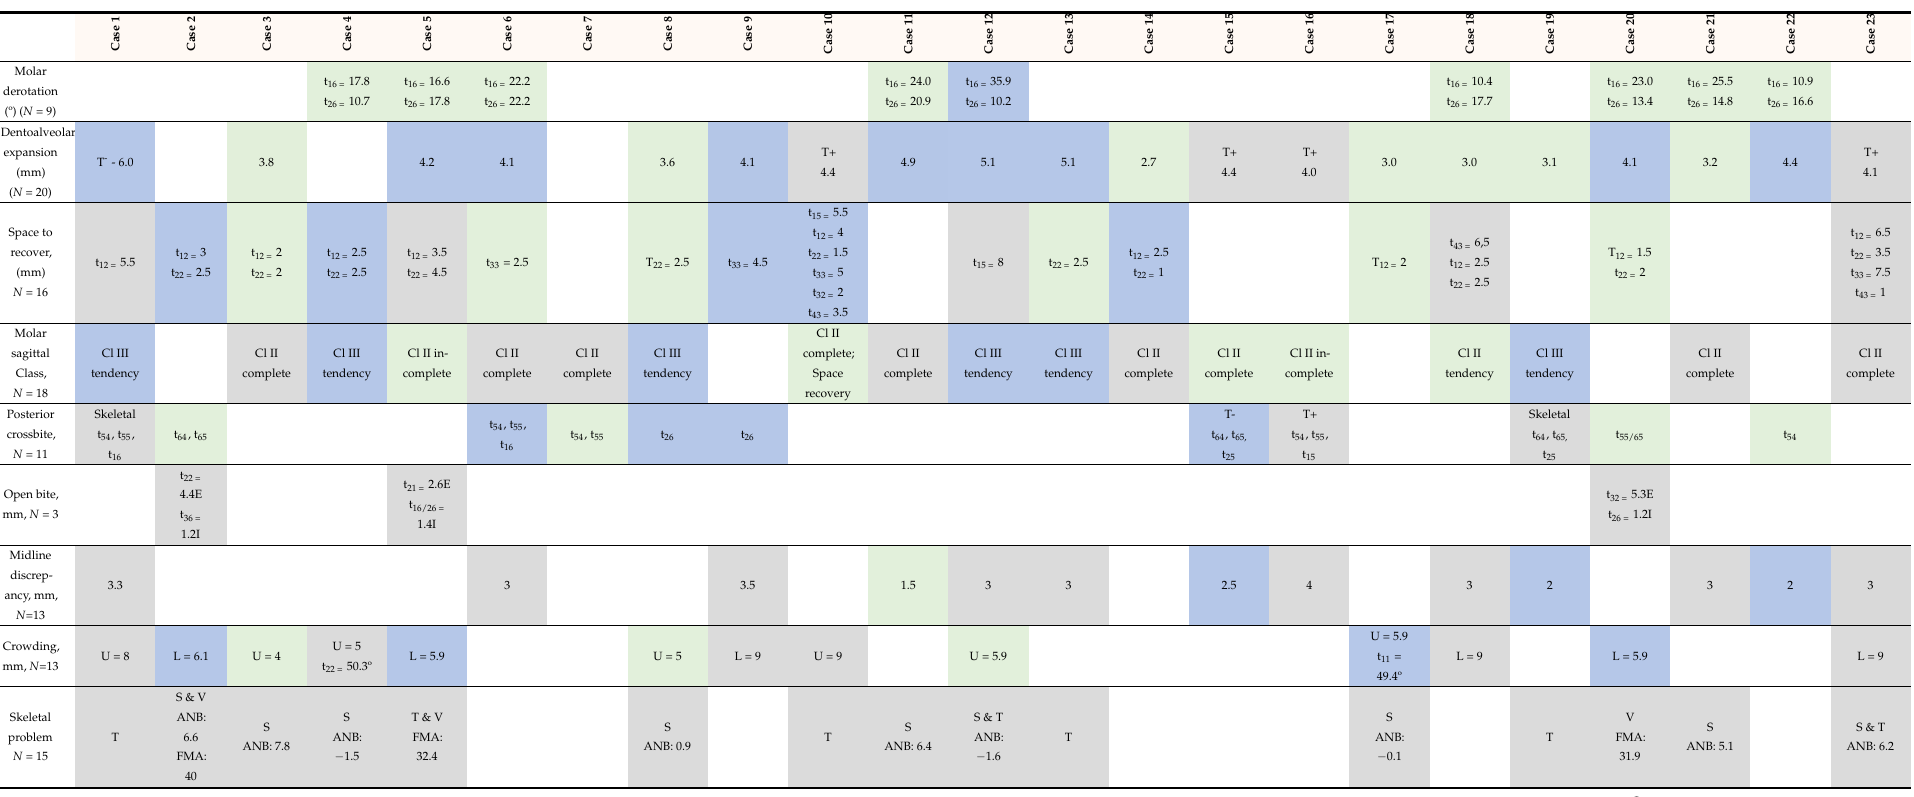
Table 3. The quantitative and qualitative assessments of the malocclusion traits to be solved for each case. These data were collected/classified at the start of the